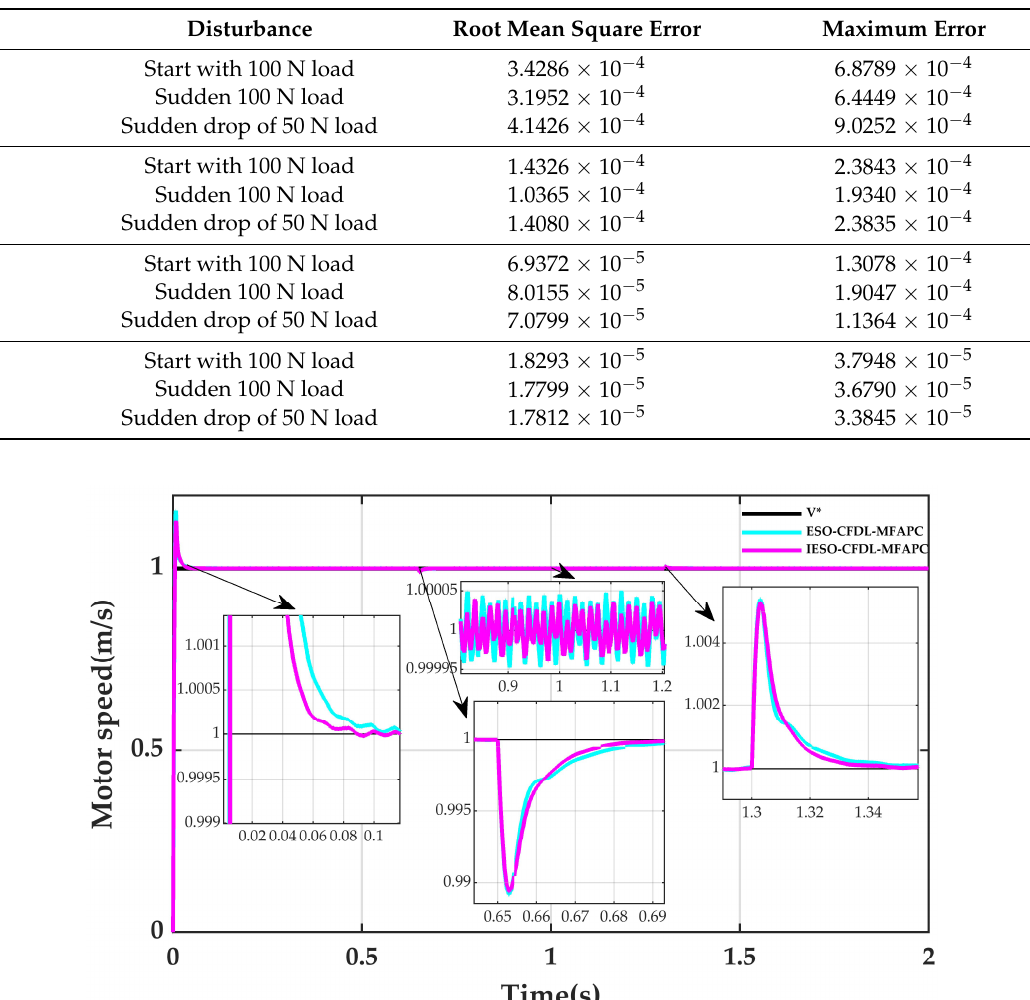
Table 4. Quantitative index of four algorithms when the load changes.